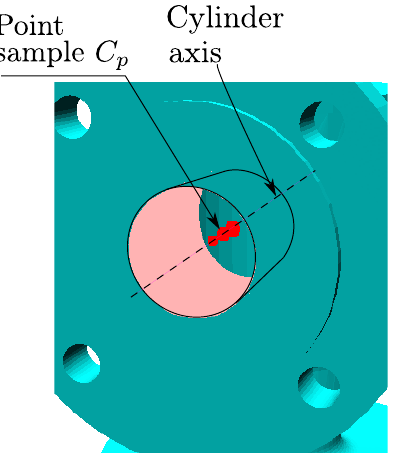
Figure 8. Set of points C p approximating the cylinder axis. Cylinder Axis direction ˆ v